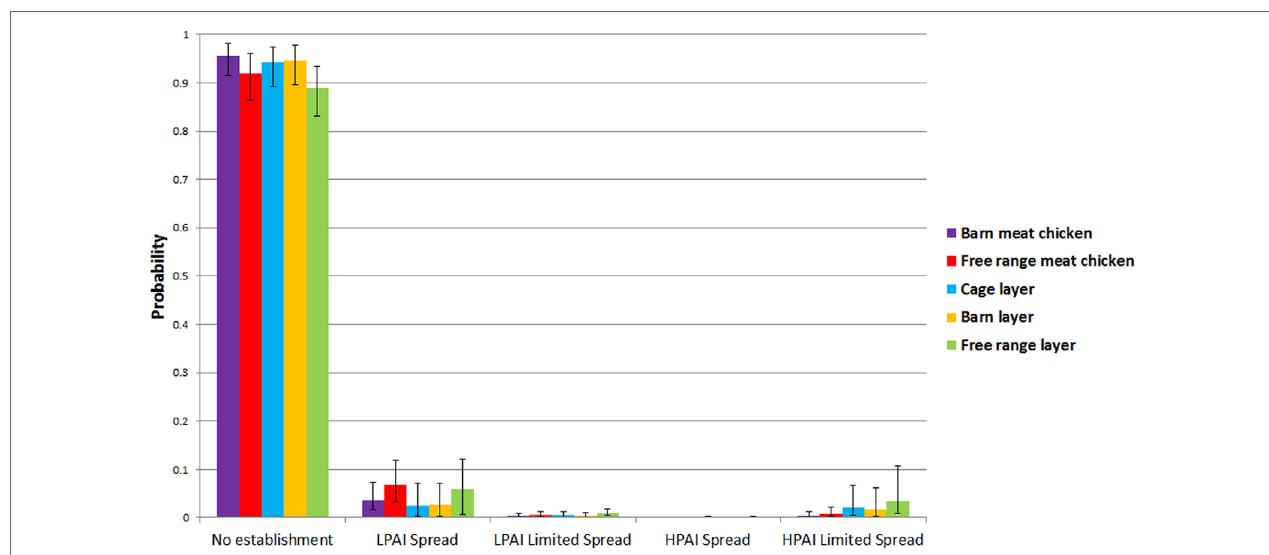
FigUre 3 | Median (5 and 95 percentiles) probabilities of no establishment and of low-pathogenic avian influenza (LPAI) and high-pathogenic avian influenza (HPAI) spread and limited spread between sheds and farms for the commercial chicken farm types (barn meat chicken, free range meat chicken, cage layer, barn layer, free range layer) after one chicken is exposed to LPAI in